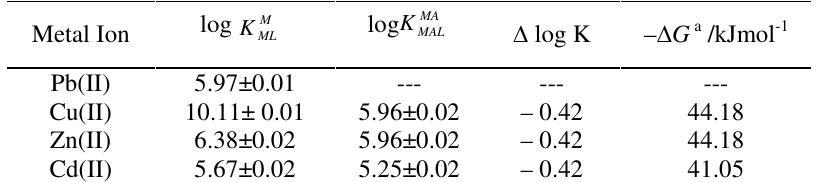
Table 4 . Stability constants of 1:1:1 ternary complexes involving Metal(II)–NAC–Histidine system at 25 °C and I=0.1 mol dm -3 KNO